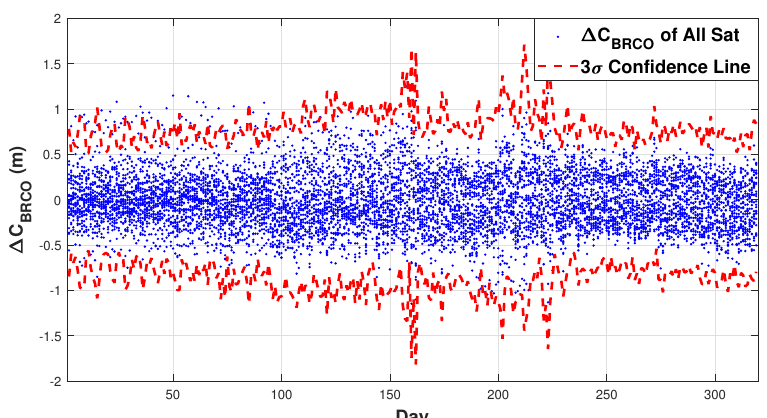
Figure 3. The difference between BRCO and PPCO.